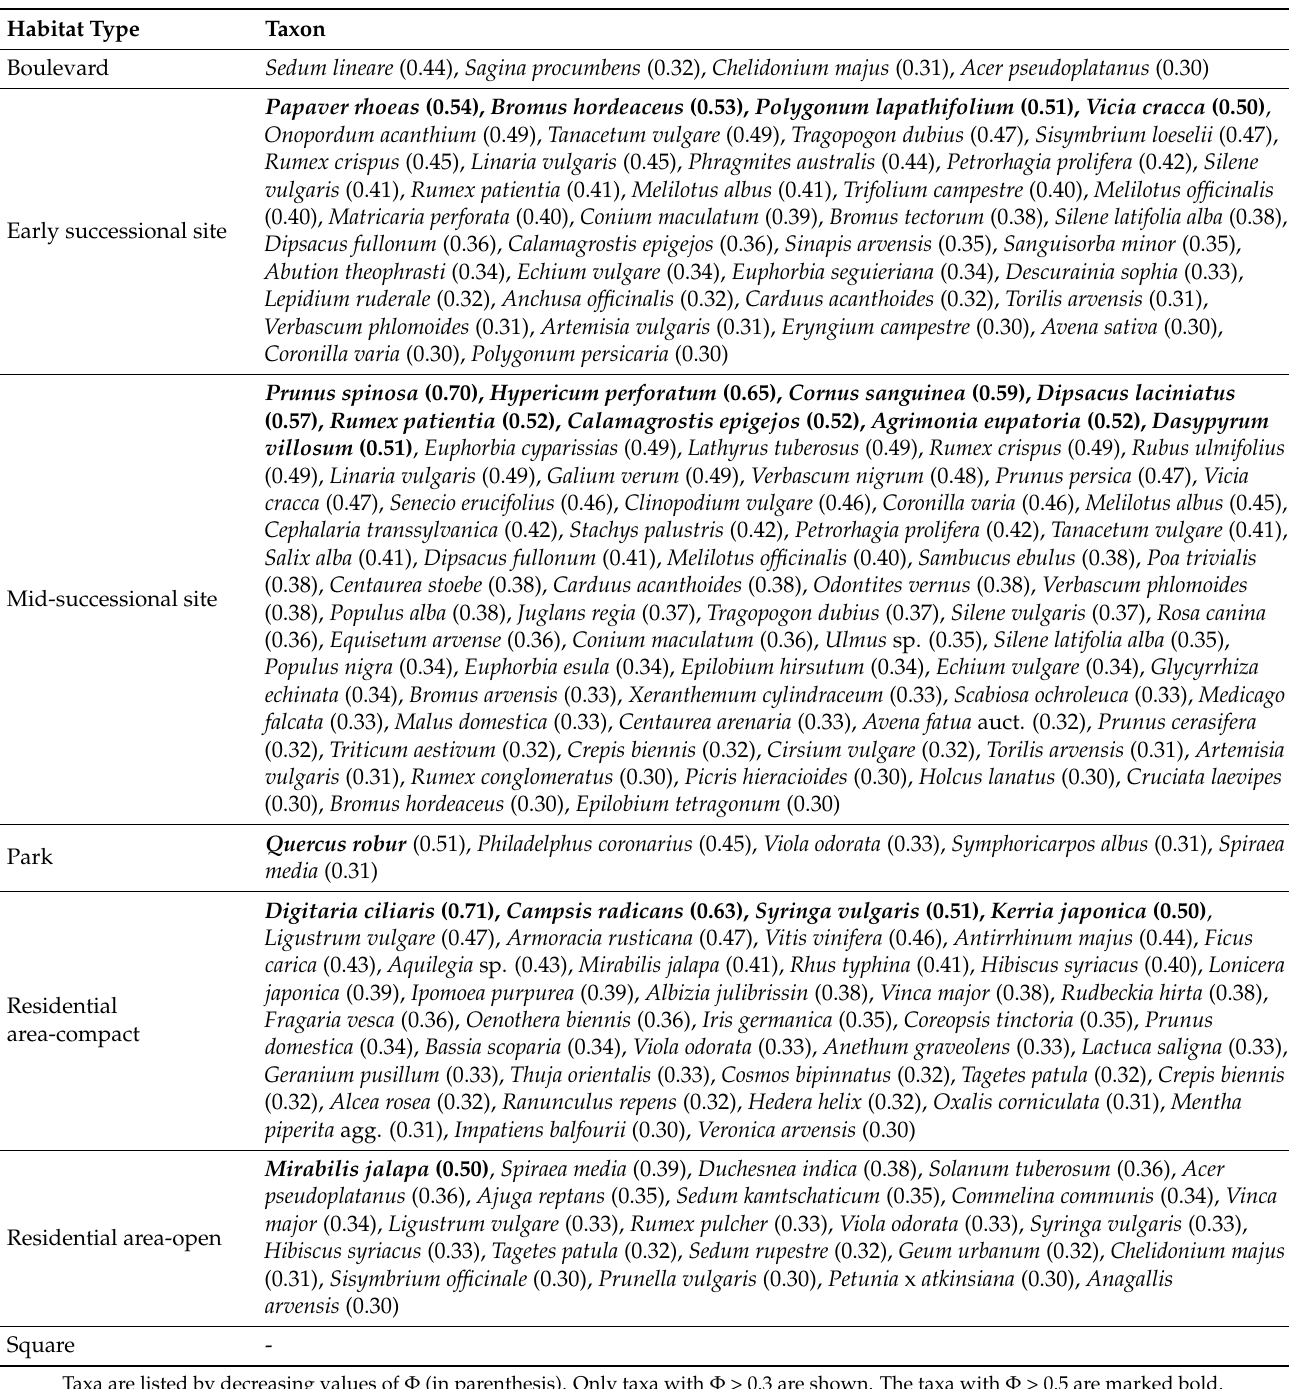
Table 1. Diagnostic plant species for studied urban habitat types in